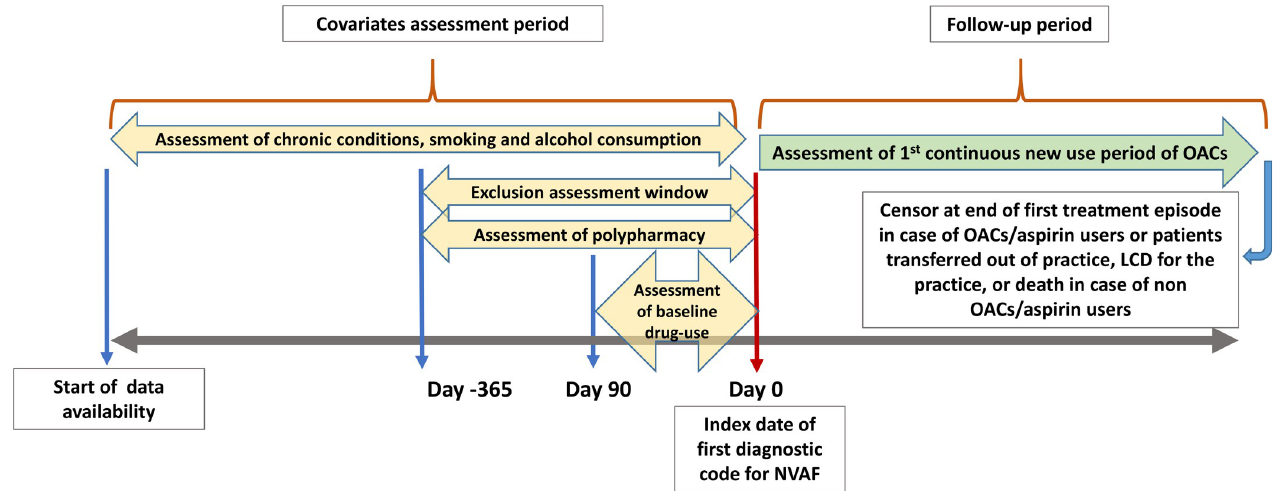
Fig 1. Graphical depiction of patient’s follow-up and assessment of OACs exposure status. LCD, late collection date; NVAF, nonvalvular atrial fibrillation; OAC, oral anticoagulant.